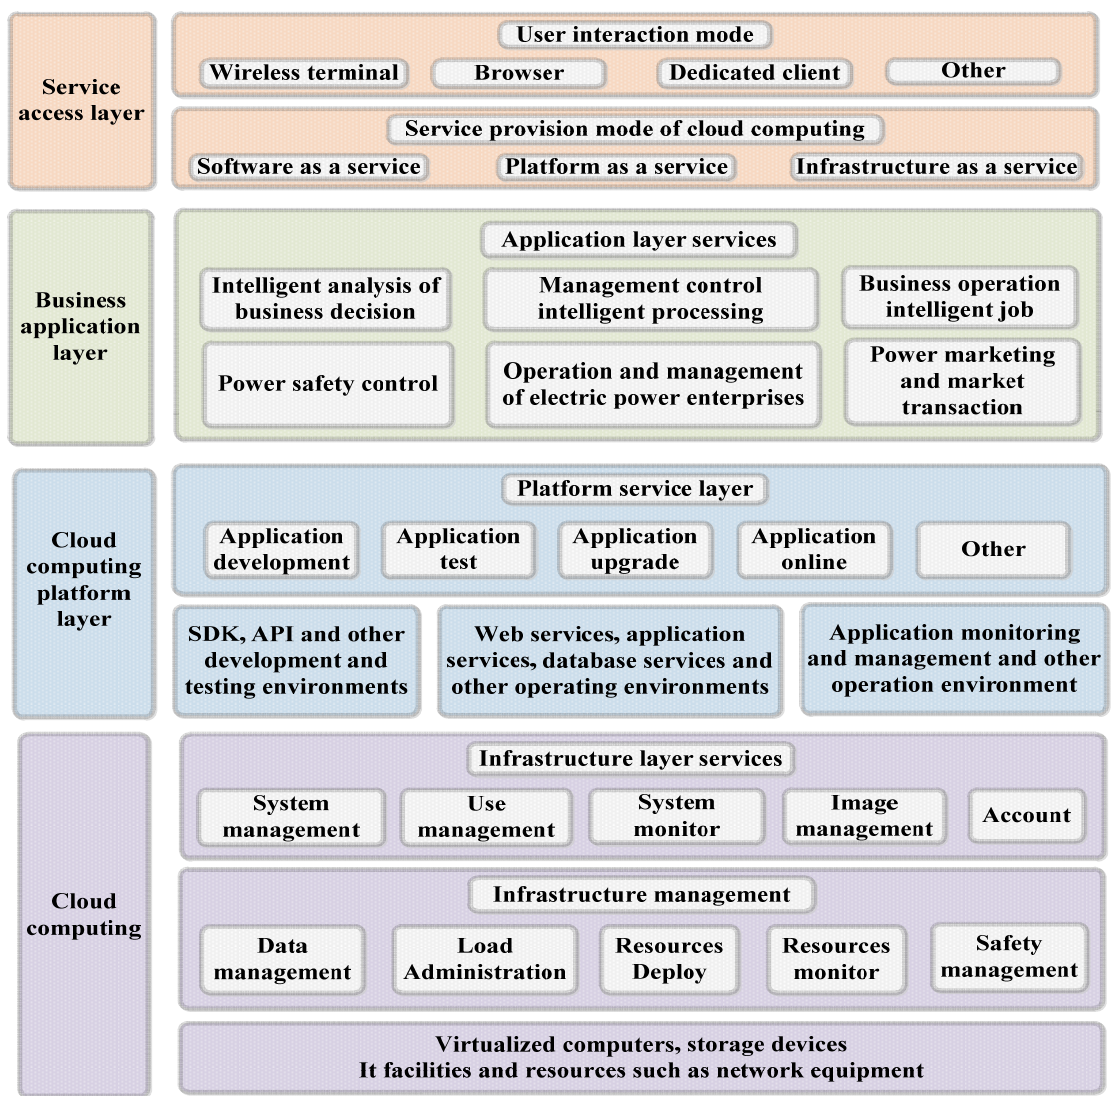
Figure 13. Structure of grid intelligent information platform.